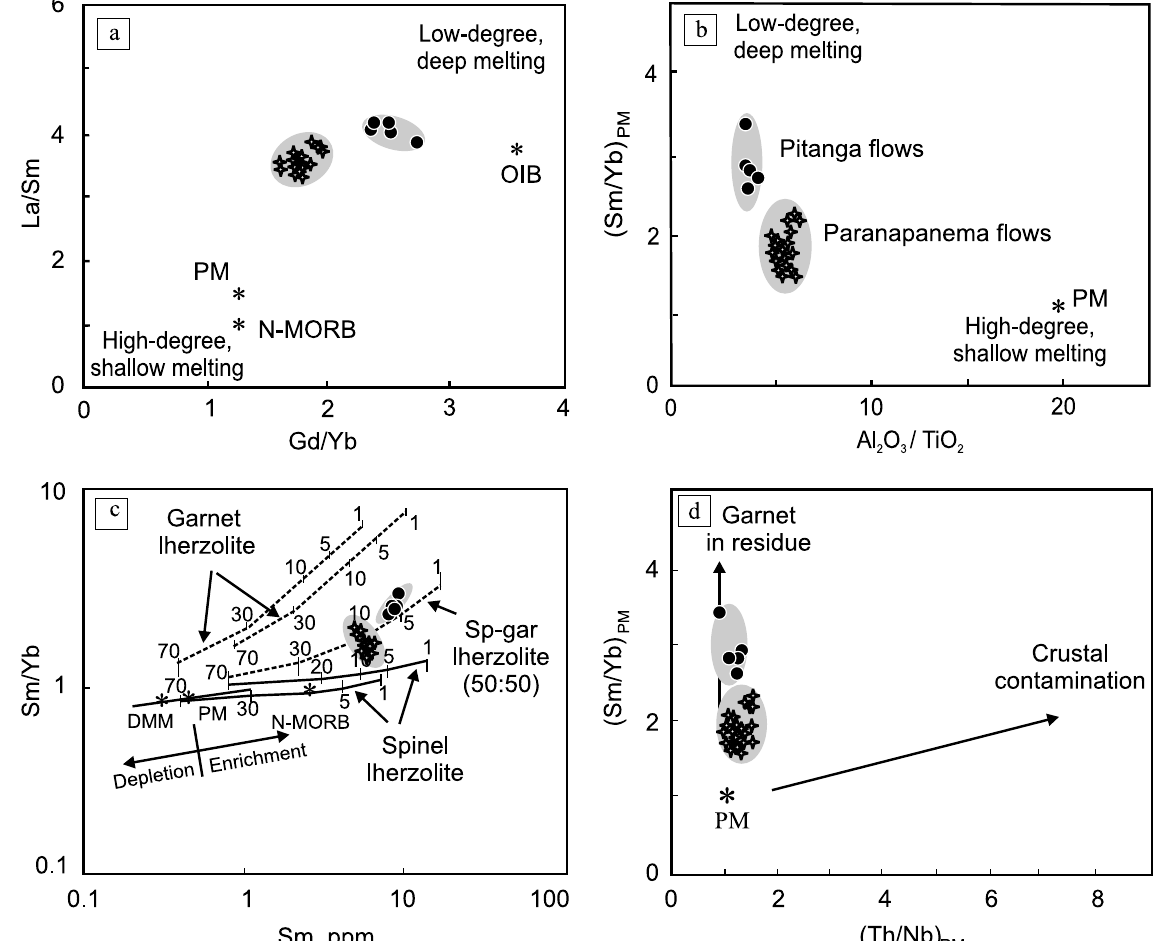
Fig. 10 – Plots of element and oxide ratios of the flood basalts from the Vista Alegre region indicating the nature and origin of the parental magmas and mantle process (a-b), plots of Sm versus Sm/Yb showing melting curves (c); the referred melting curves are after Aldanmaz et al. 2000. Also, (Th/Nb) PM ratios (d) indicate the contribution of crustal contamination in the basalts; all diagrams based in Wang et al. (2007). Primitive mantle (PM) and N-MORB compositions are from Sun and McDonough (1989). Sp = Spinel; gar =